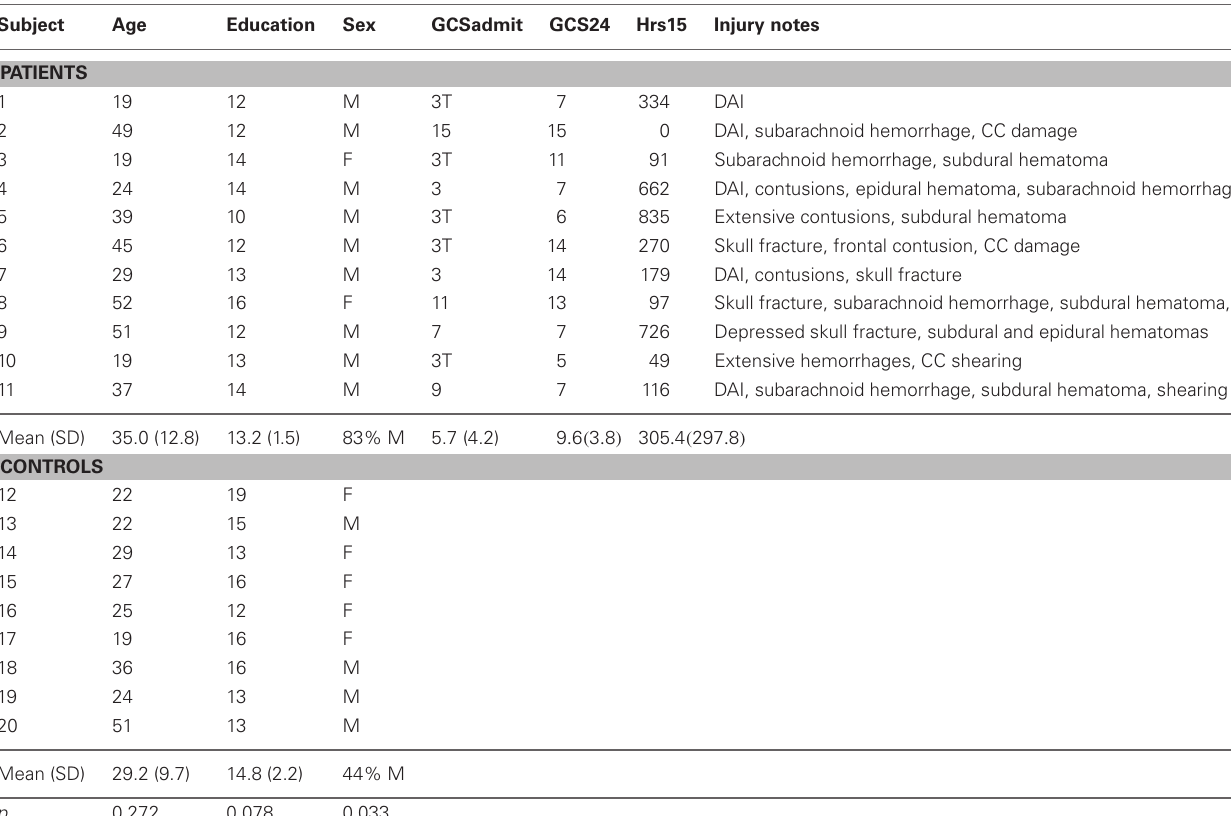
Table 1 | Individual level subject demographics for patients and controls and select patient injury